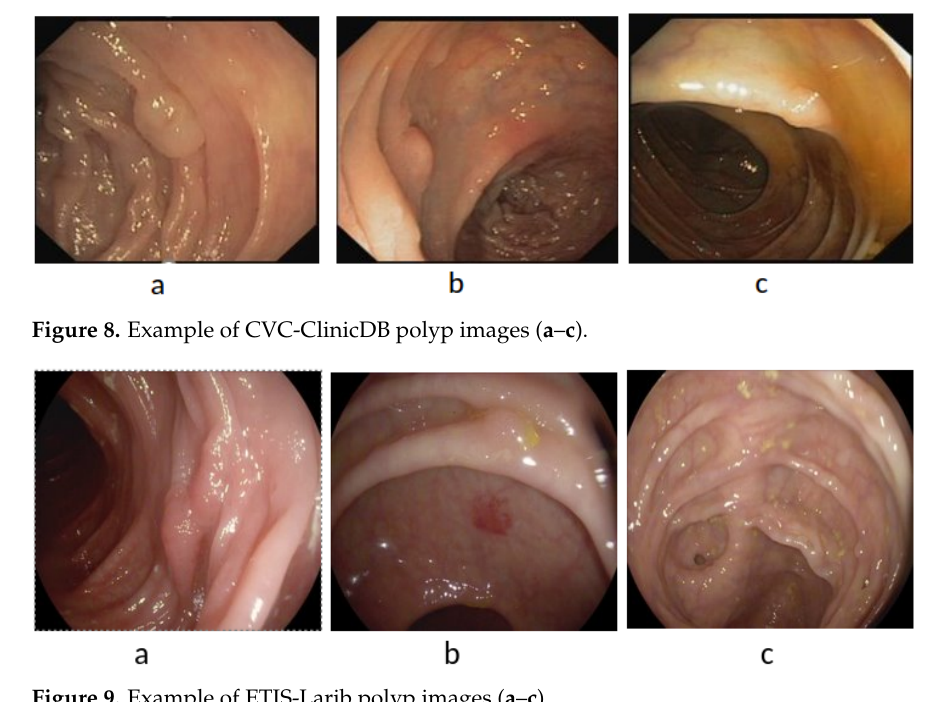
Figure 9. Example of ETIS-Larib polyp images ( a – c